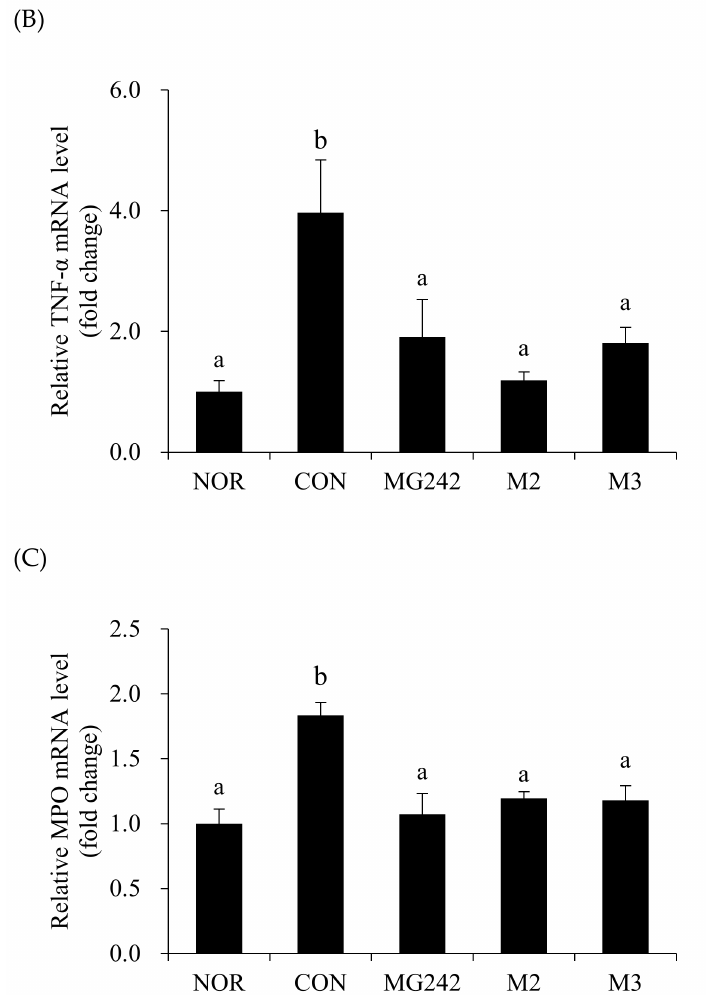
Figure 2. Pro-inflammatory biomarkers in BV-induced mice. RT-PCR analysis of the mRNA ex- pression of ( A ) IL-1 β , ( B ) TNF- α , and ( C ) myeloperoxidase (MPO). Glyceraldehyde-3-phosphate dehydrogenase (GAPDH) was used as a housekeeping gene to normalize all samples. Data are